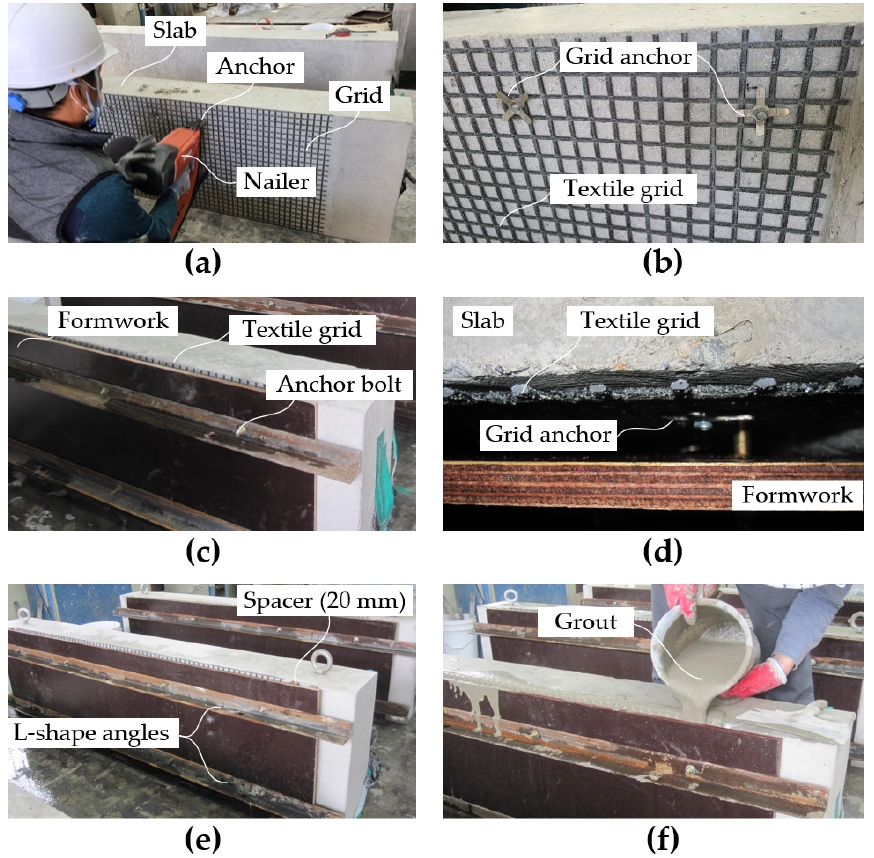
Figure 5. TRC strengthening process: ( a ) installation of textile grid; ( b ) textile grid and anchors; ( c ) formwork for S-1 series specimens; ( d ) grouting space; ( e ) formwork for S-2 series specimens; and ( f ) grout filling process.